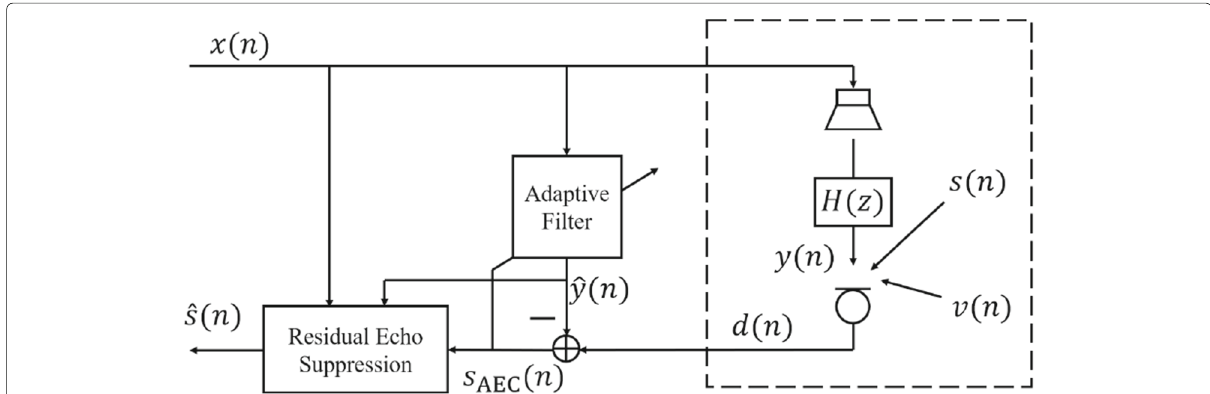
Fig. 1 The diagram of AEC system with RES